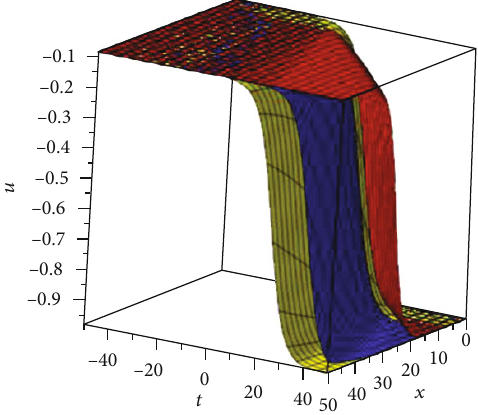
Figure 2: 3D plot of solution (78) for various values of α , and β = 1, p ffiffiffiffiffiffiffiffiffiffiffiffiffiffiffiffiffiffiffiffiffi ffiffiffiffi p λ 2, μ = 0 : 4, A = 3, E = 0 : 5 . c = E λ 2 − 4 E μ ,